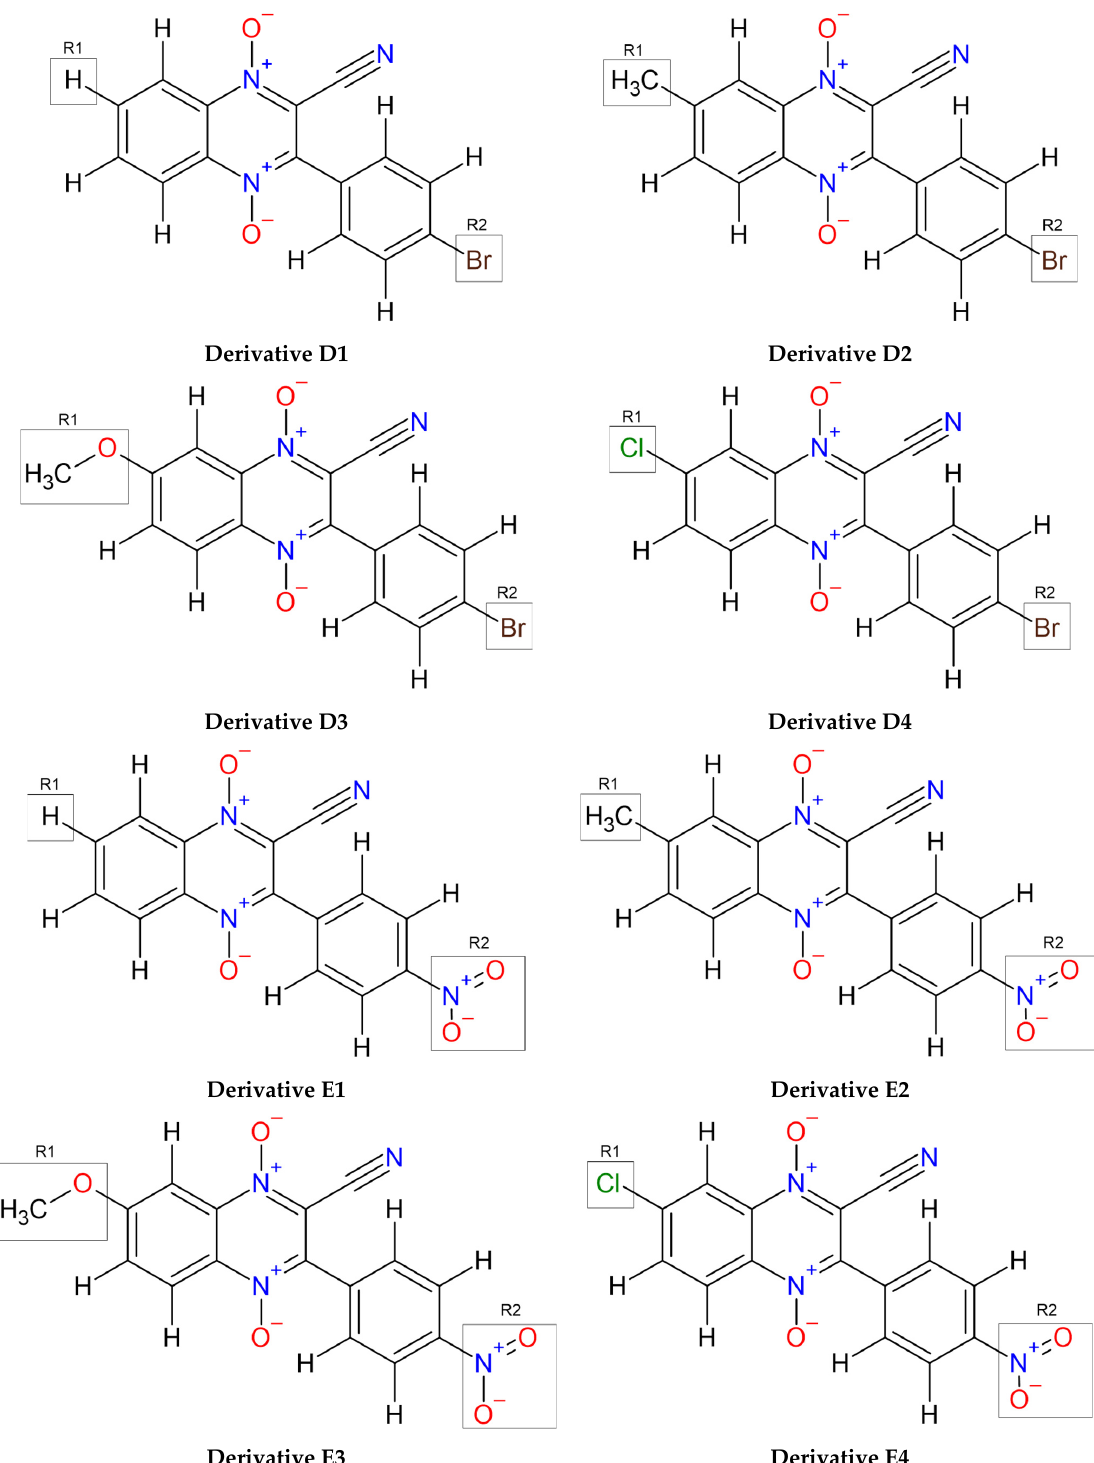
Figure A1. Structures of the 3-Aryl-Quinoxaline-2-Carbonitrile 1,4-Di-N-Oxide derivatives drawn with ChemSketch Freeware [19]. The substituent R1 and R2 groups are labeled.